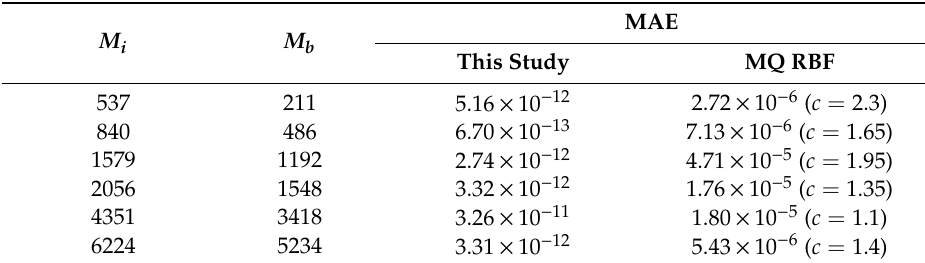
Table 2. Results comparison between this study and the multiquadrics radial basis function with the optimal shape